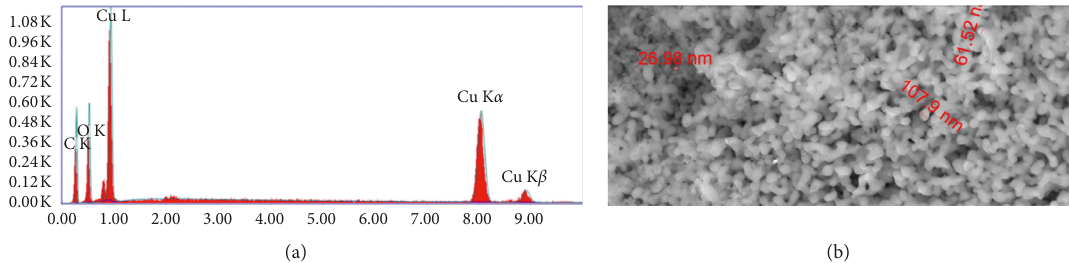
Figure 8: EDX and SEM images of CuO obtained by thermal decomposition at 550C ° starting from copper glutamic arginine mixed ligands complex.